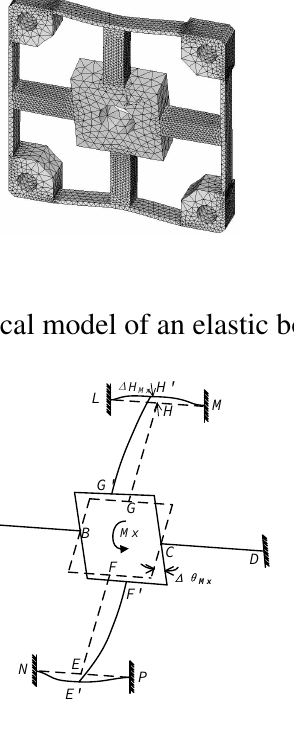
Figure 8. Deformation of an elastic body under M